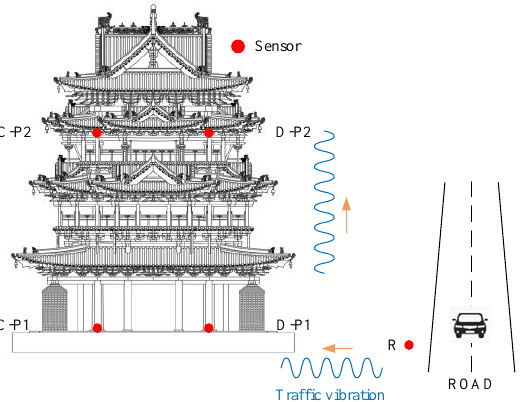
Figure 13. The vertical layout of the measurement points.